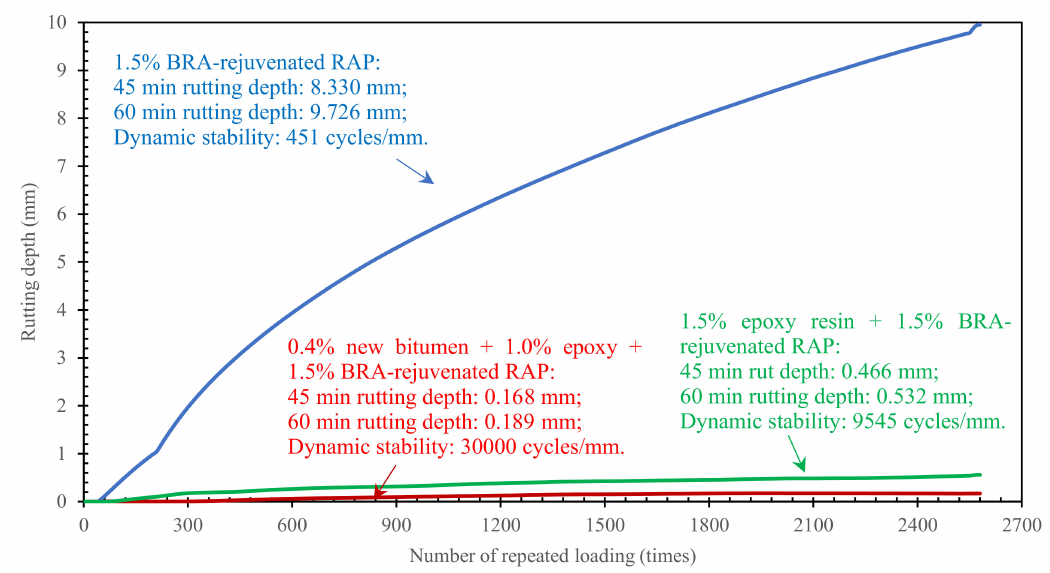
Figure 9. Rutting depth of BRA-rejuvenated